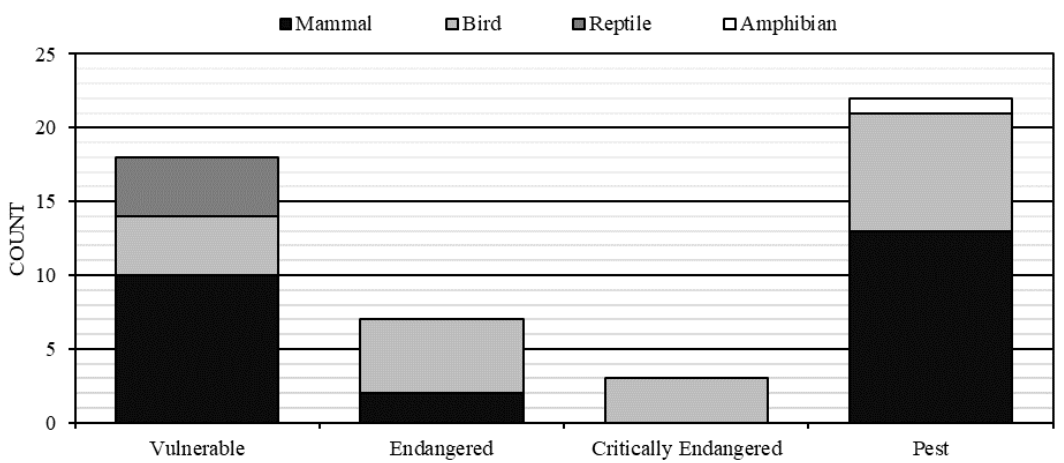
Figure 3. Count of fauna species identified in each class across conservation status. Bar chart presenting the count of identified species at each level categorised by Species Profile and Threats database: critically endangered, endangered, vulnerable or pest species (x axis). Columns divided by species class. Black—mammal, light grey—birds, dark grey—reptiles, white—amphibian. An average of nine (SE. = 0.19) threatened species and nine (SE = 0.20) invasive species were